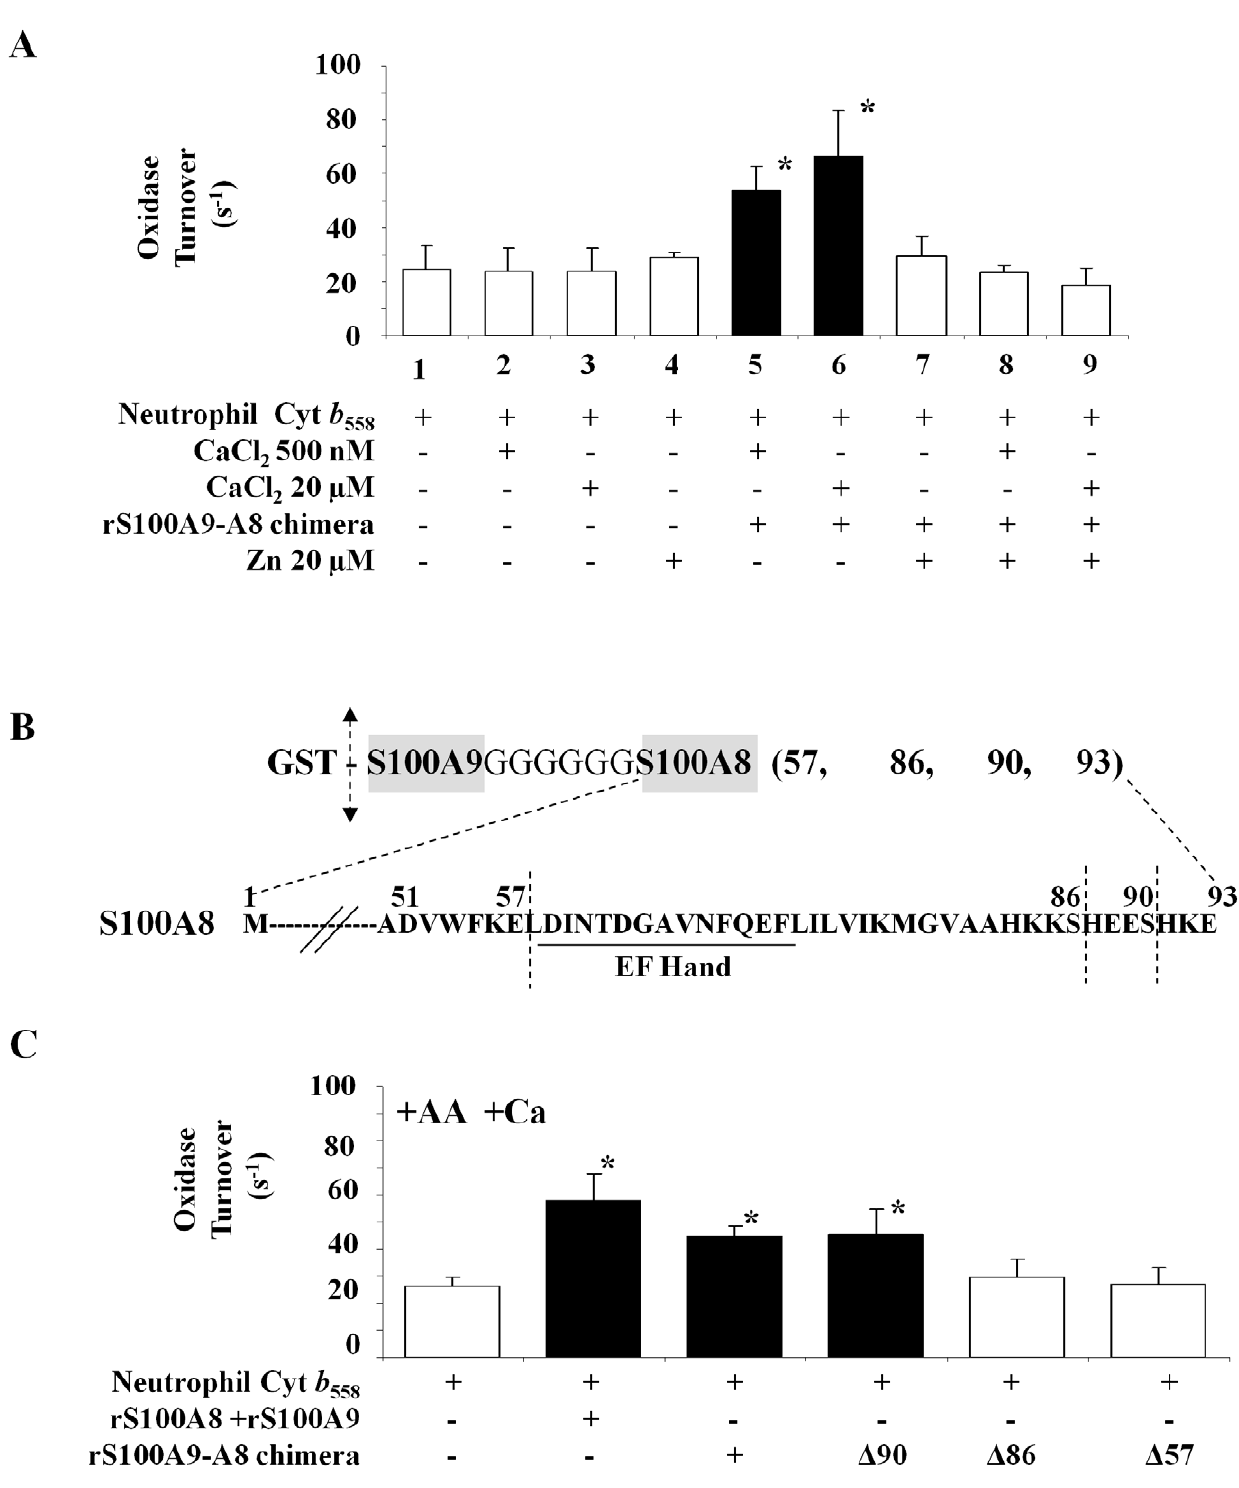
Figure 5. NADPH oxidase activation by rS100A9-A8 chimera full length and truncated forms. (A) Effect of zinc versus calcium on the NADPH oxidase activity measured in a cell-free assay as described in Figure 4 and in Materials and Methods. Cytochrome b 558 (0.2 pmol) was incubated in the presence (or not) of (20 m M or 500 nM) calcium loaded rS100A9-A8 chimera, and then with FAD, GTP c S, MgCl 2 and an optimal amount of arachidonic acid (1 mM). The effect of pre-incubation of S100 chimera proteins with zinc versus calcium was tested on NADPH oxidase activity. The conditions are cytochrome b 558 incubate alone (1), with calcium (2–3), with zinc (4), with rS100A9-A8 chimera plus calcium (5–6), with rS100A9-A8 chimera plus zinc (7) and with rS100A9-A8 chimera plus calcium then plus zinc (8–9). NADPH oxidase activity was expressed as turnover (s 2 1 ). Number of experiments n=6. * , 0.05 compared to control (NADPH oxidase activity of cytochrome b 558 plus calcium). (B) Schematic representation of the C terminal sequence of full length and truncated S100A8 of the recombinant chimera proteins. The four chimera S100A9-full length S100A8 named rS100A9-A8, S100A9-truncated S100A8 named rS100A9-A8 D 90, S100A9-A8 D 86, or rS100A9-A8 D 57 were expressed in E. coli as